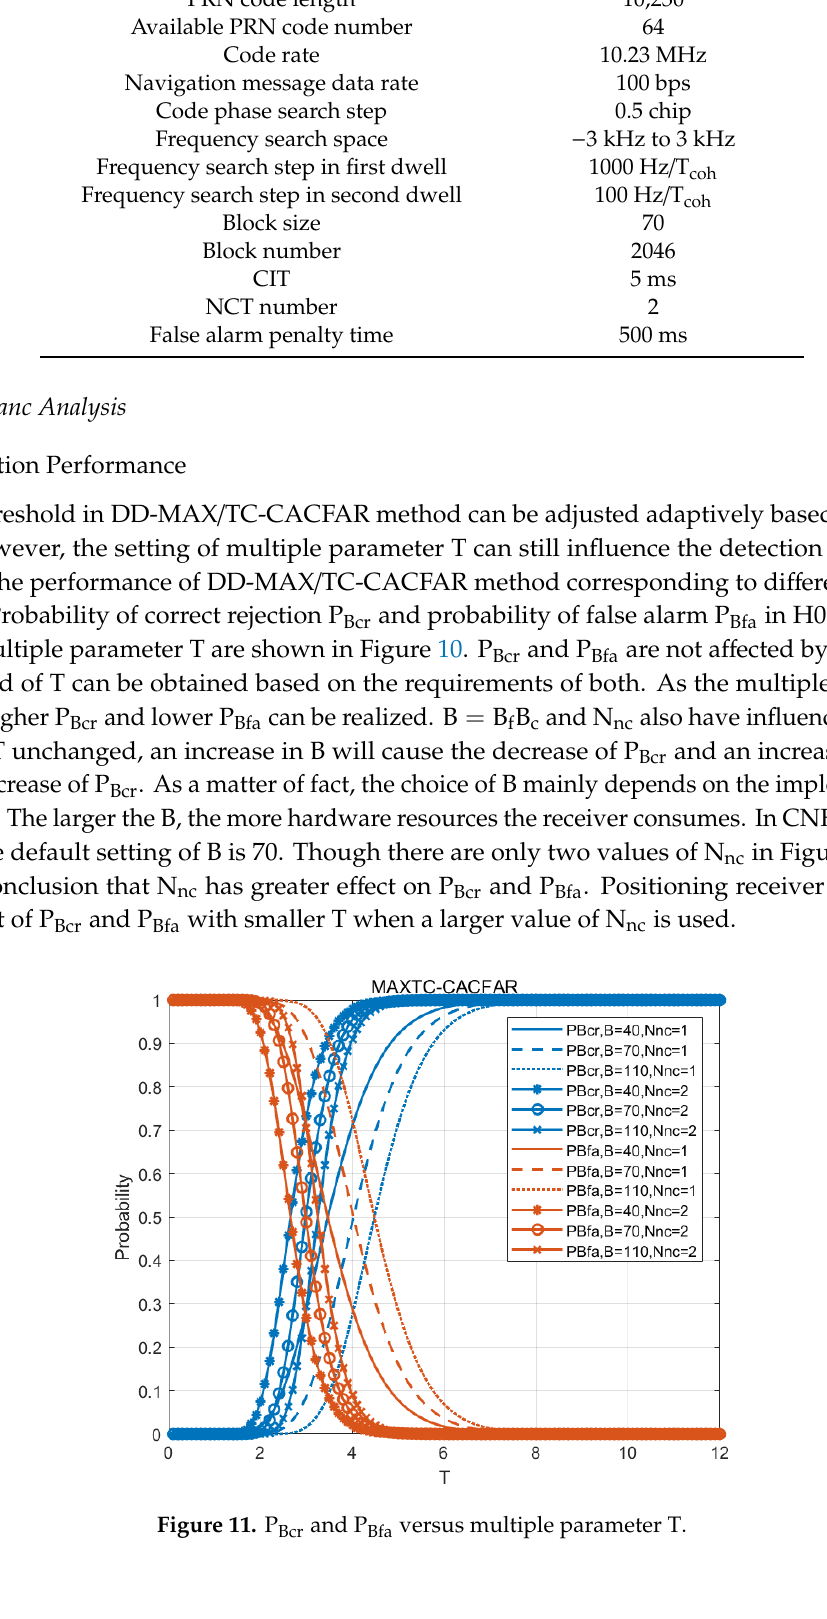
Figure 12. P (cid:2886)(cid:2914) and P (cid:2886)(cid:2923) versus multiple parameter T . Three other different methods— MAX/TC, DD/MAX, and TDCC method—are simulated here as the comparison [26,30]. Detection performance of TDCC method is in terms of one cell in search space while the other three methods are in terms of one block. Therefore, the corresponding probabilities in the TDCC method are rewritten as Equation (40).